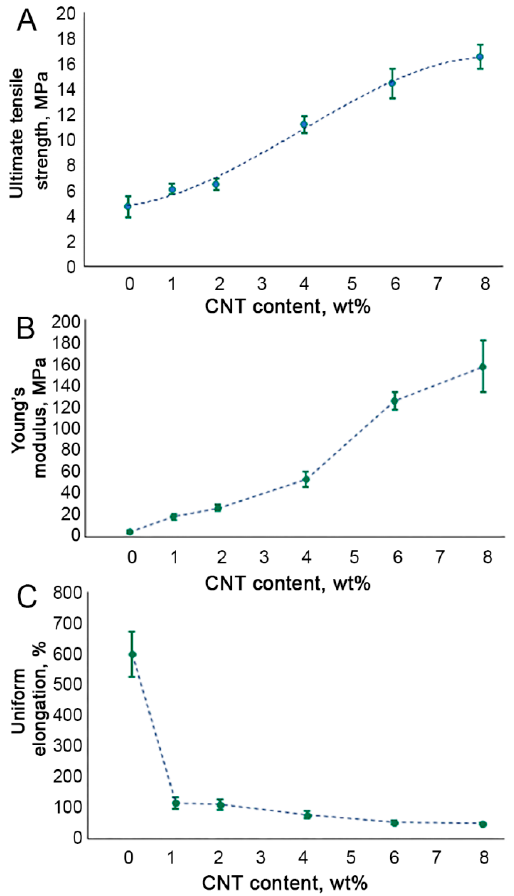
Figure 5. Tensile testing of SIBS–CNT films of different nanofiller concentrations: ( A ). the ultimate tensile strength; ( B ). Young’s modulus; ( C ). uniform elongation.